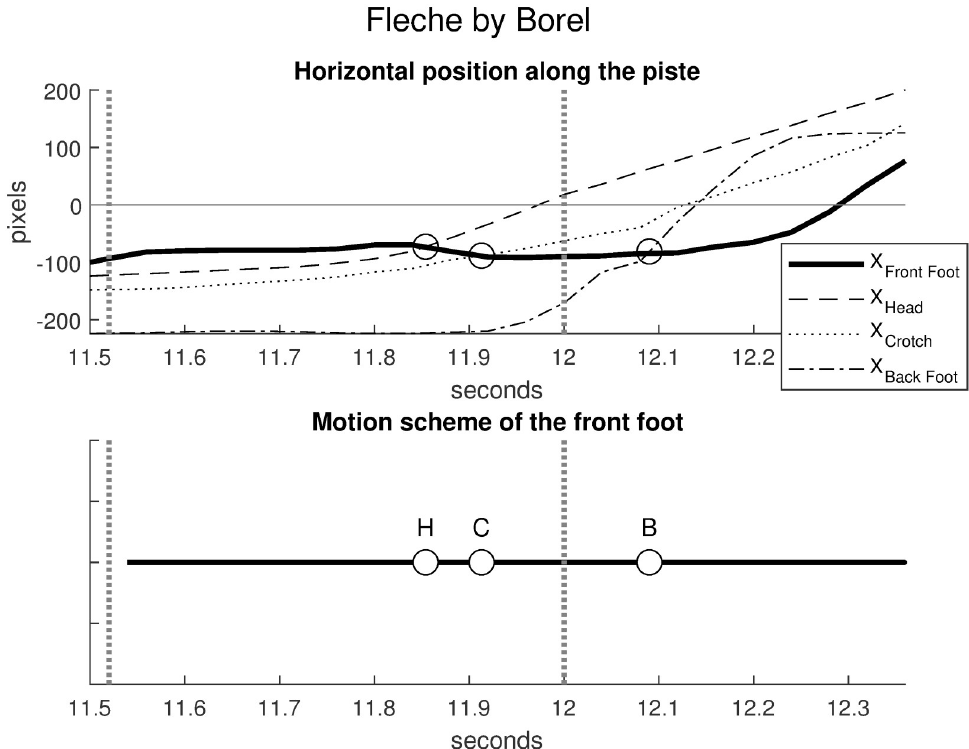
Fig 27. Borel’s fleche in a duel Borel-Svichkar (World Fencing Championships Wuxi, 2018). The touch at 12 seconds and the start 0.5 seconds before the touch are represented by dotted vertical lines. The front foot abscissa remains virtually stable while it is sequentially overtaken by the head (state H), the crotch (state C) and the back foot (state B). The motion scheme of the front foot has three states H, C, B. Source of the original video: [21].